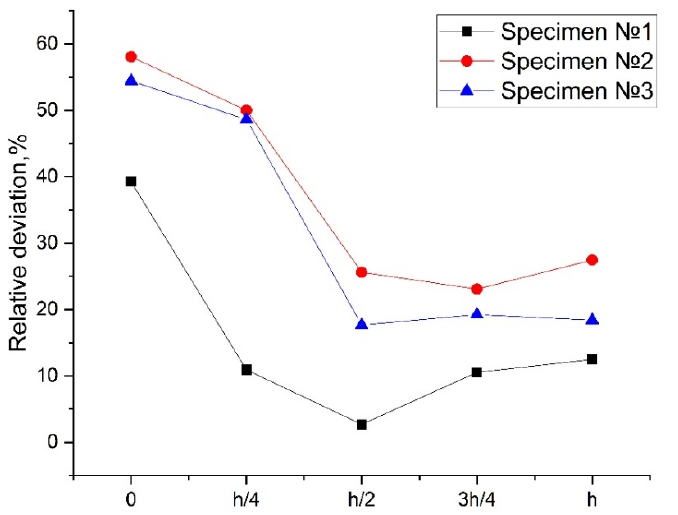
Figure 9. Dependencies of the values of the dendritic thickness relative deviation along the height of the specimens.